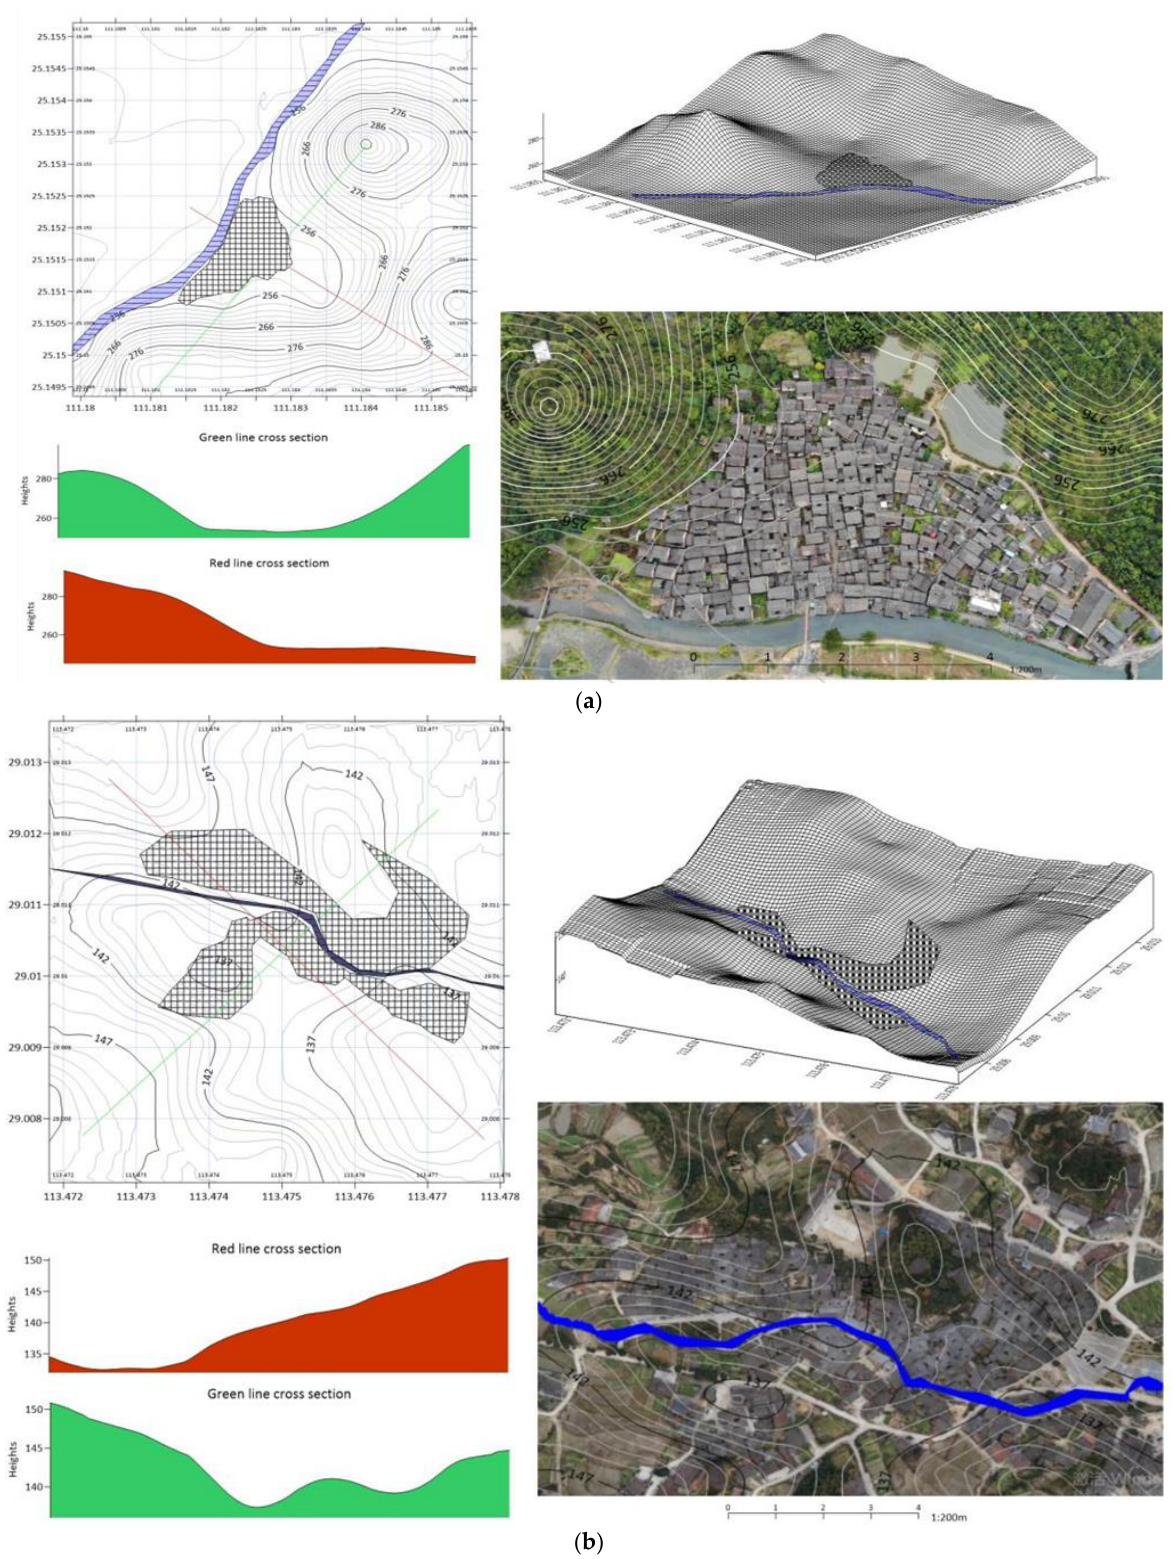
Figure 4. The topography and cross-section of ( a ) ShangGanTang village; ( b ) ZhangGuYing village.